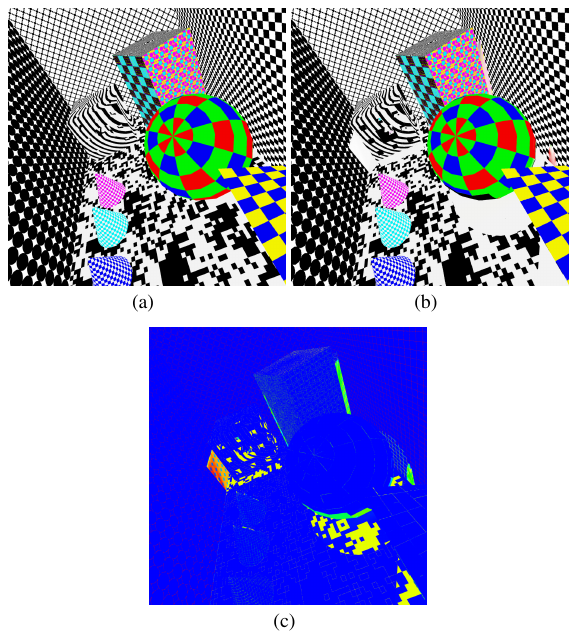
Figure 6. Texture mapping evaluation for Pattern Valley (a) Original RGB image sample (b) Image after texture mapping (c) Deviation heat